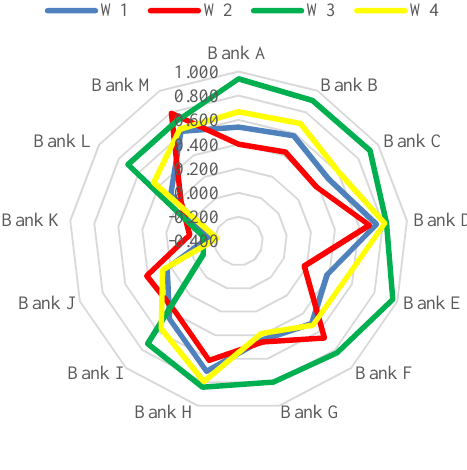
Figure 3. Resistance of commercial banks to potential COVID-19 pandemic impact determined by the Hellwig method taking into account different weighting systems (Option